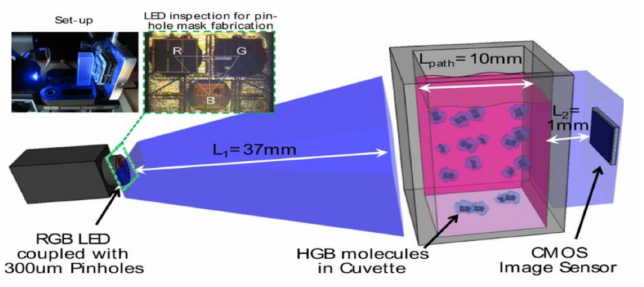
Figure 4. Experimental setup for hemoglobin concentration measurement using CIS. Figure adapted with permission from